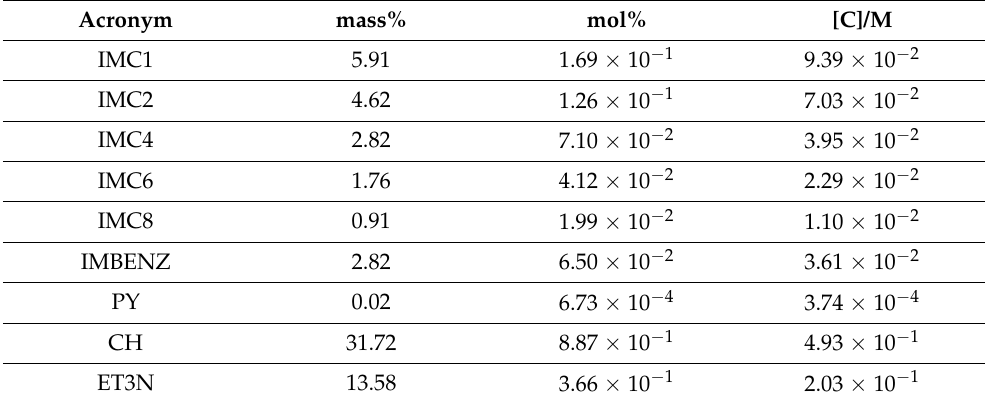
Table 1. Maximum solubility, in mass percentage (mass%), mol percentage (mol%) and molar concentration (M), of GDILs in H 2